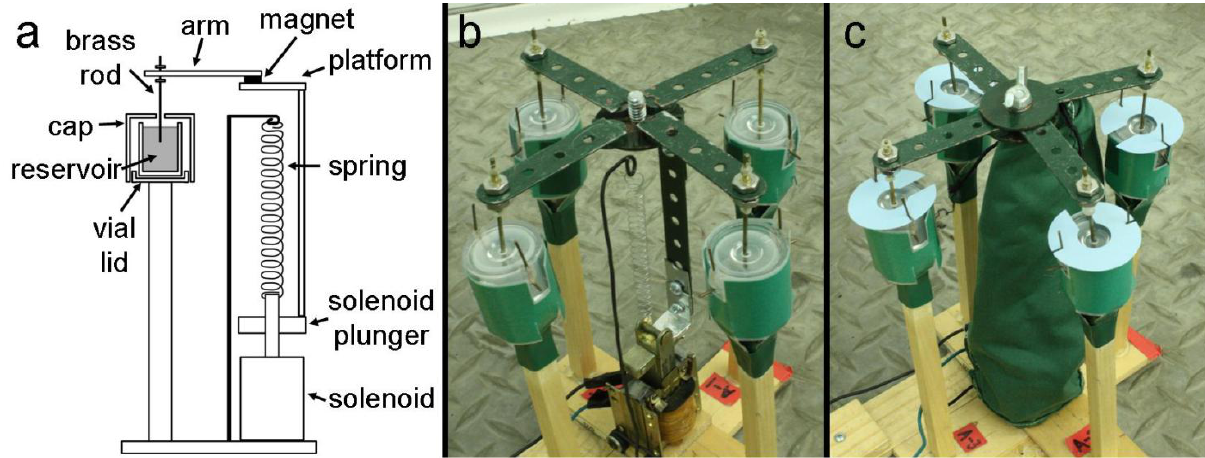
Figure 1. Flobots, shown as a diagram of the major components (a), partly disassembled (b), and fully assembled (c). and, when power to the solenoid is turned off, lifted back up by a spring. I provide a list of the parts and materials I used in the online supplementary material (Appendix